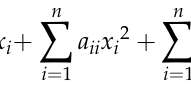
Figure 6. Comparing the accuracy of computational fluid dynamics (CFD) results with published experimental results (Setoguchi et al., 2002); ( a ) C T , ( b ) C A and ( c ) η . (Horizontal axis: flow coefficient).